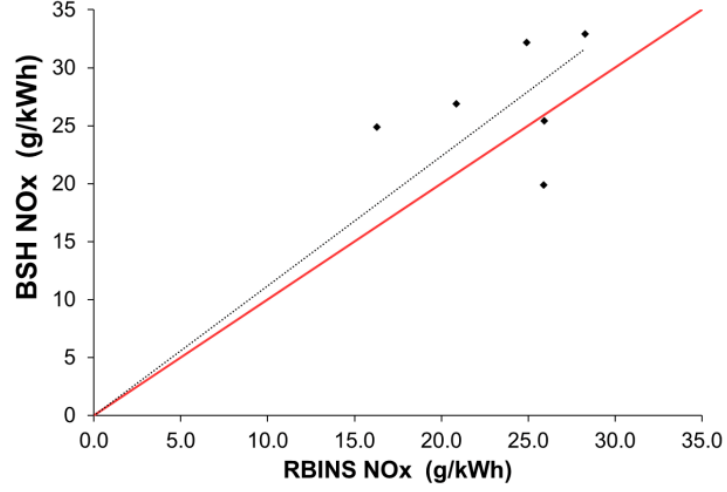
Figure 5. Comparison of NO x measurements of RBINS (BE) with BSH (DE) ( ♦ ); the black dotted line represents the linear regression, and the red line represents a perfect correlation (x = y).